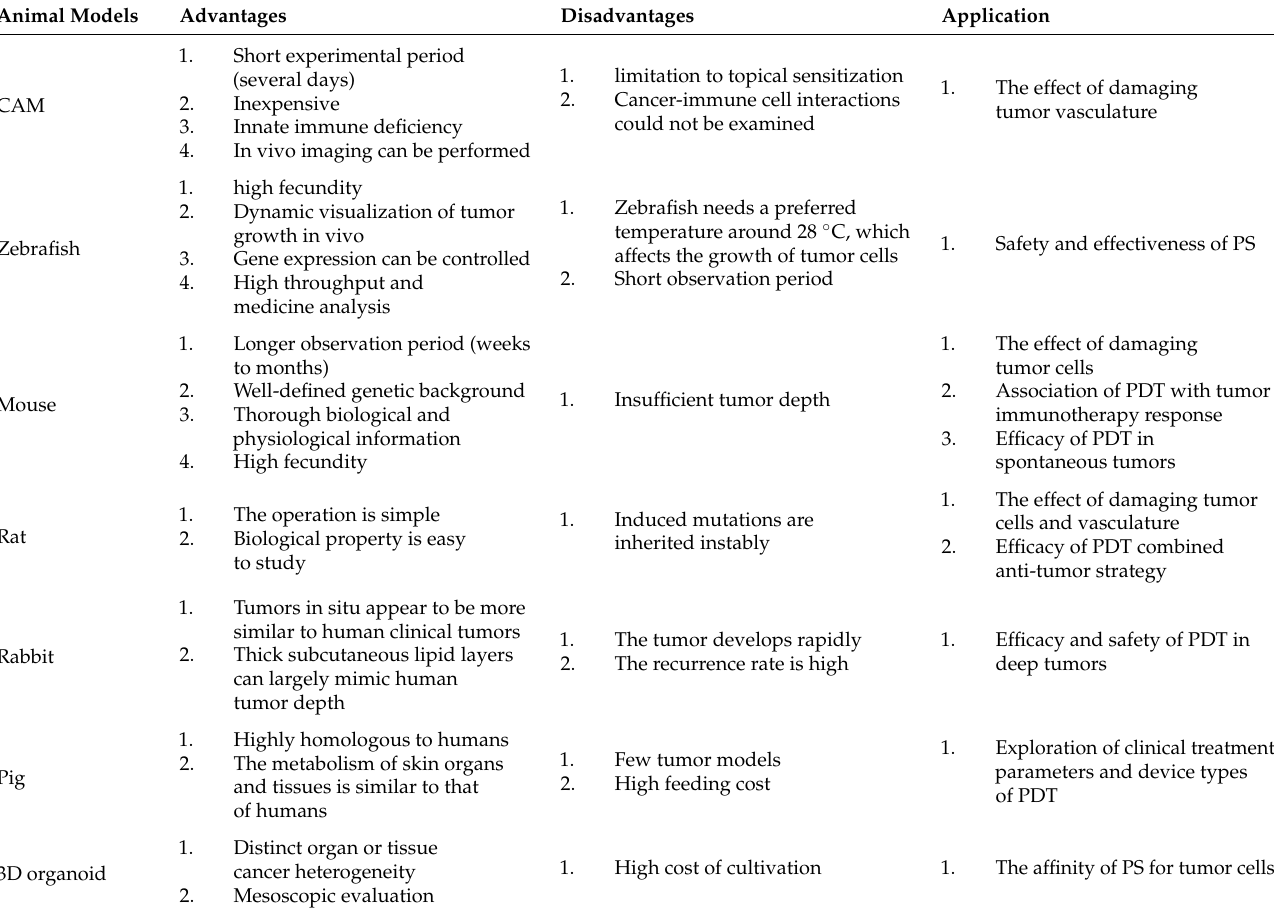
Table 7. Comparison of various models in antitumor studies of